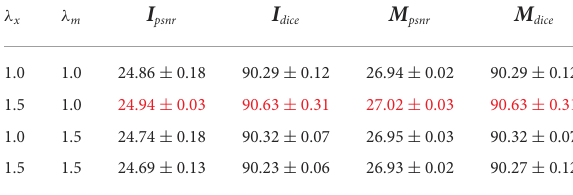
TABLE 5 Ablation study of λ x and λ m in L loss function.